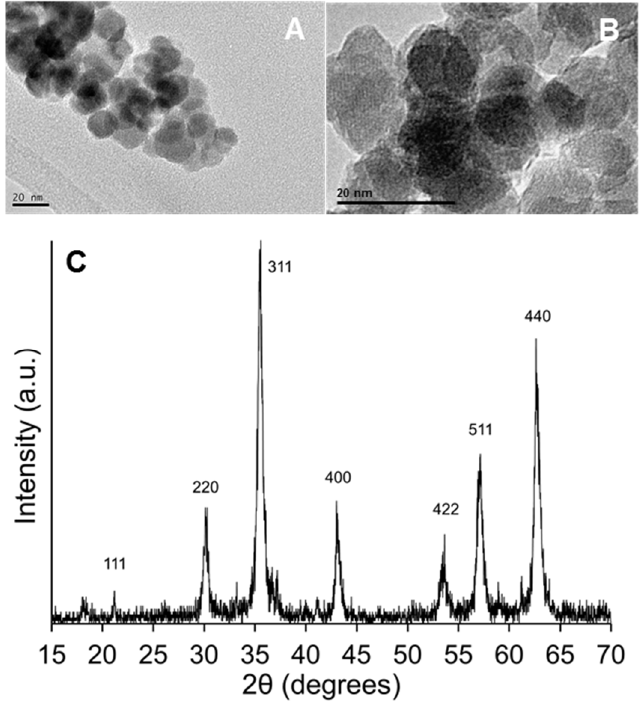
Figure 1. TEM images ( A , B ) and low-angle X-Ray diffraction pattern ( C ) of Fe 3 O 4